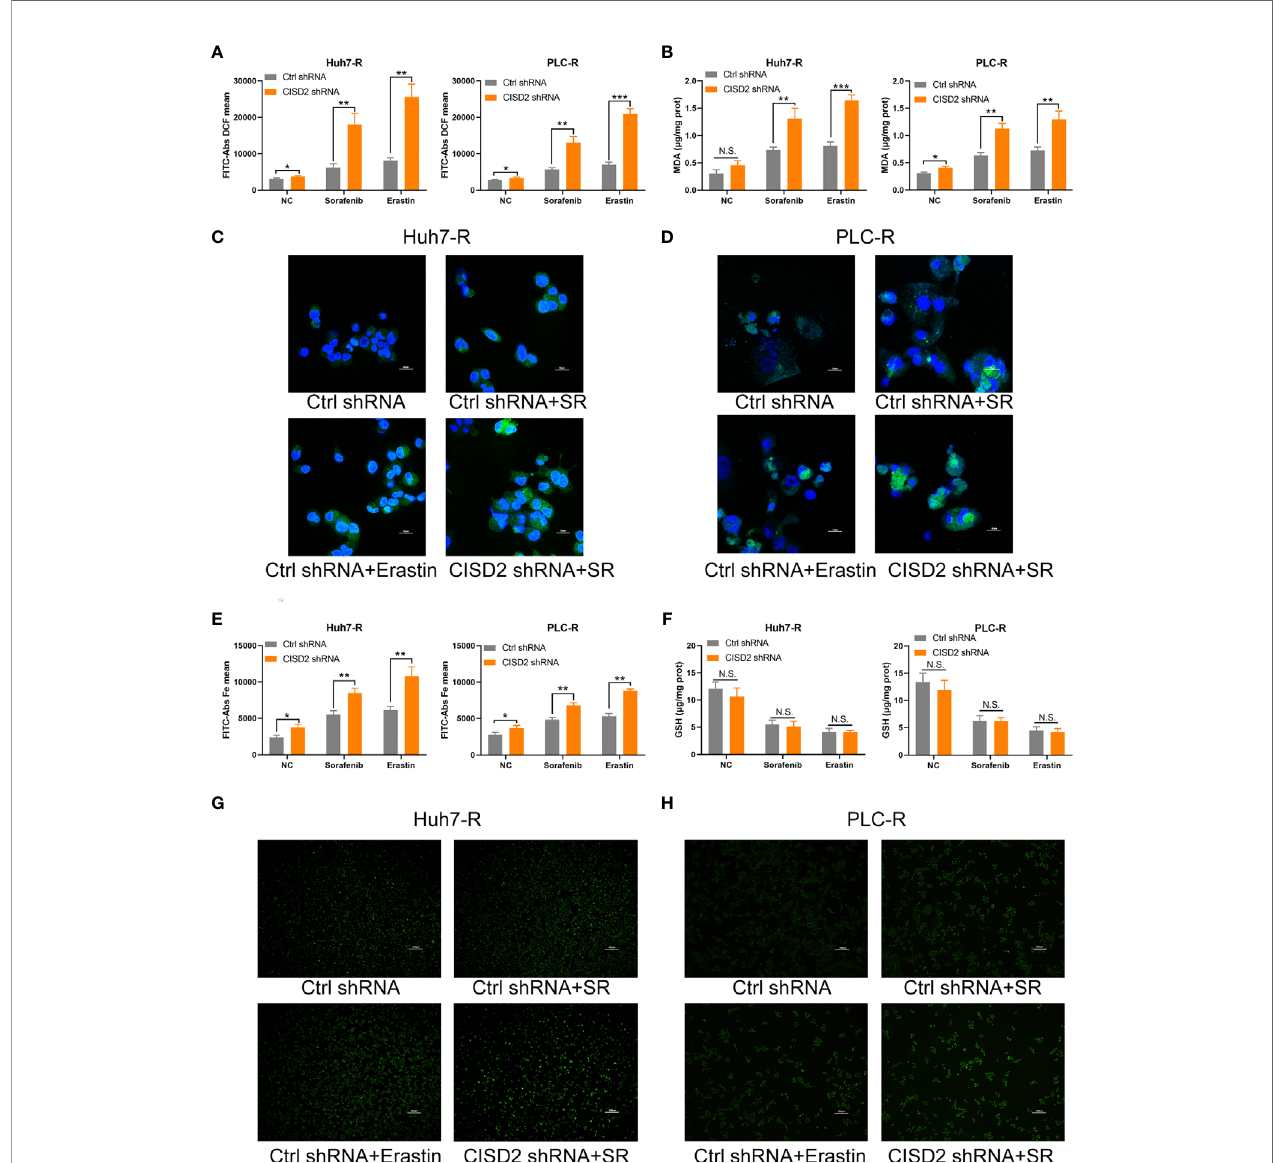
FIGURE 4 | Knockdown of CISD2 promotes ferroptosis in sorafenib-resistant cells. (A) Flow cytometry was used to detect the expression level of ROS under treatment with sorafenib (10 m mol) or transfected CISD2 shRNA, and erastin (10 m mol) as positive control. (B) MDA kit was used to detect the expression level of MDA under treatment with sorafenib (10 m mol) or transfected CISD2 shRNA, and erastin (10 m mol) as positive control. (C, D) Immuno fl uorescence was used to detect the expression of ROS by adding DCFH-DA under treatment with sorafenib (10 m mol) or transfected CISD2 shRNA. (E) Flow cytometry was used to detect the expression level of iron ions under treatment with sorafenib (10 m mol) or transfected CISD2 shRNA, and erastin (10 m mol) as positive control. (F) GSH kit was used to detect the expression level of GSH under treatment with sorafenib (10 m mol) or transfected CISD2 shRNA, and erastin (10 m mol) as positive control. (G, H) Immuno fl uorescence was used to detect the expression level of iron ions under treatment with sorafenib (10 m mol) or transfected CISD2 shRNA. (n = 3, *P < 0.05, **P < 0.01, ***P < 0.001 versus Ctrl shRNA, N.S. means no signi fi